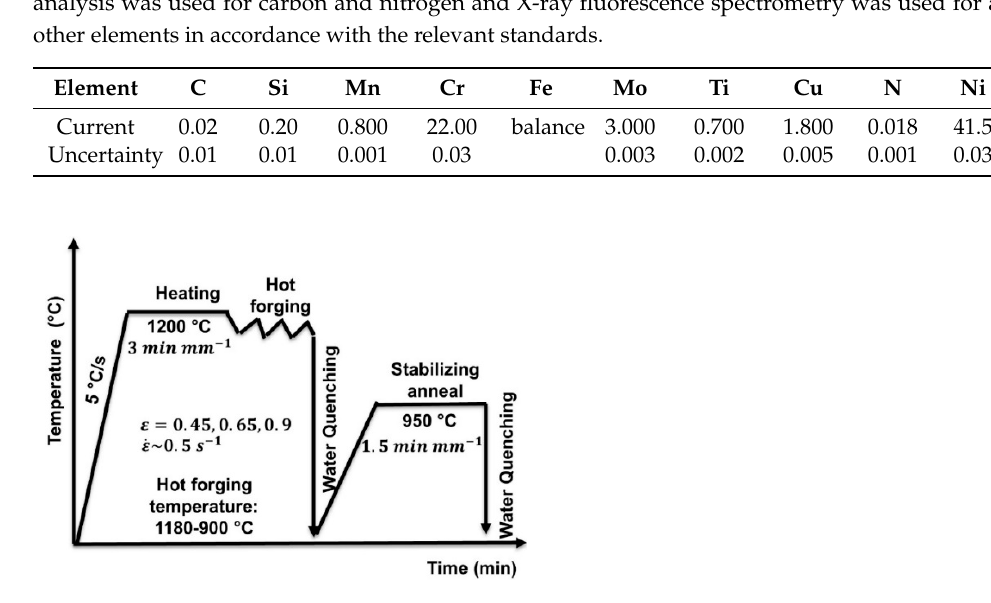
Figure 1. Schematic diagram showing the thermomechanical processing cycle and soft annealing